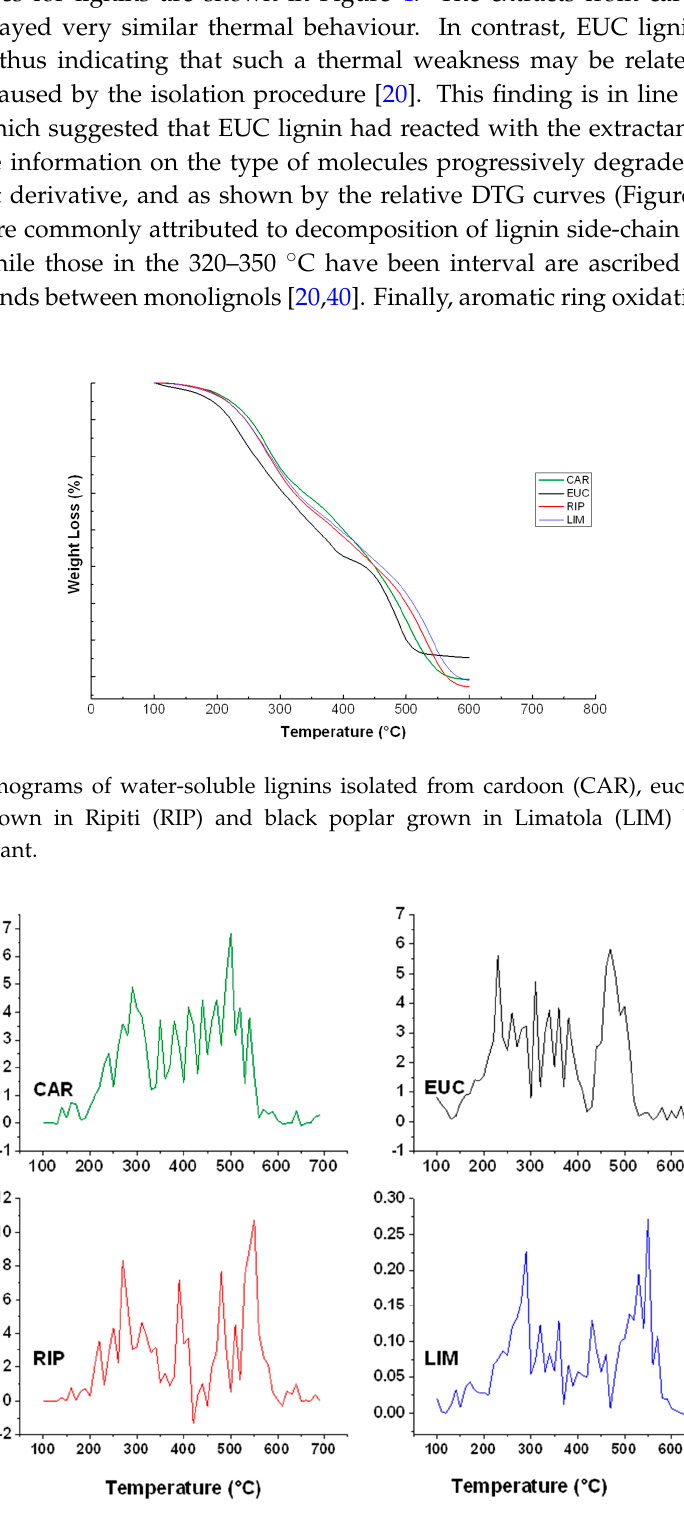
Figure 5. DTG curves of water-soluble lignins isolated from cardoon (CAR), eucalyptus (EUC), black poplar grown in Ripiti (RIP) and black poplar grown in Limatola (LIM) by an alkaline oxidative extractant.